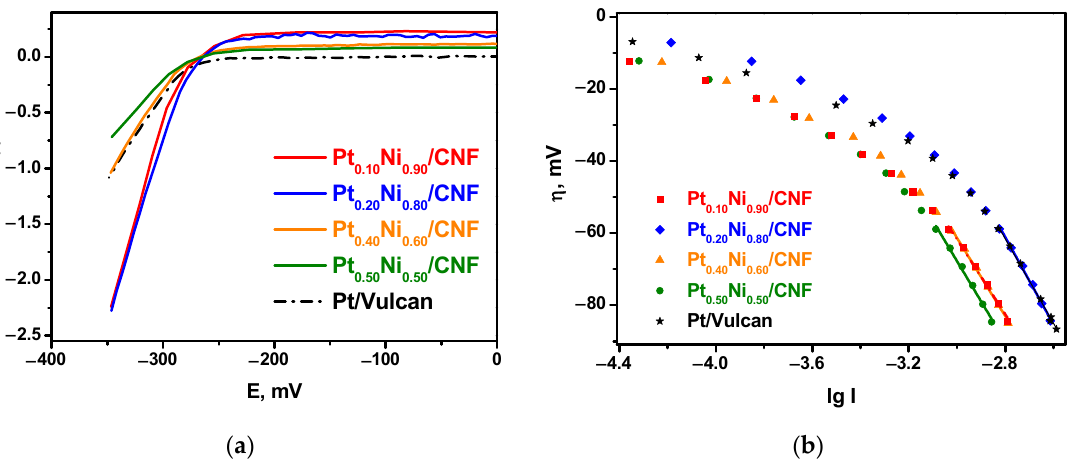
Figure 9. The catalytic activity of Pt 1 − x Ni x /CNF composites in electrochemical hydrogen evolution reaction (HER): ( a ) linear potential sweep in 0.1 M H 2 SO 4 at a sweep rate of 10 mV/s; ( b ) Tafel dependences of hydrogen evolution processes.